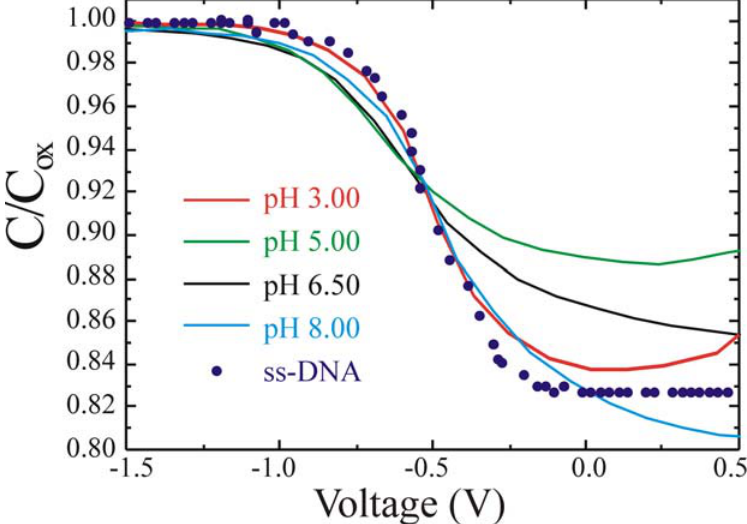
Figure 12. Normalized Capacitance Voltage curves of the reference sample as a function of the electrolyte pH (3.0 red line, 5.0 green line, 6.5 black line, 8 light blue line) and in presence of complementary ssDNA at pH of 6.5 (dark blue